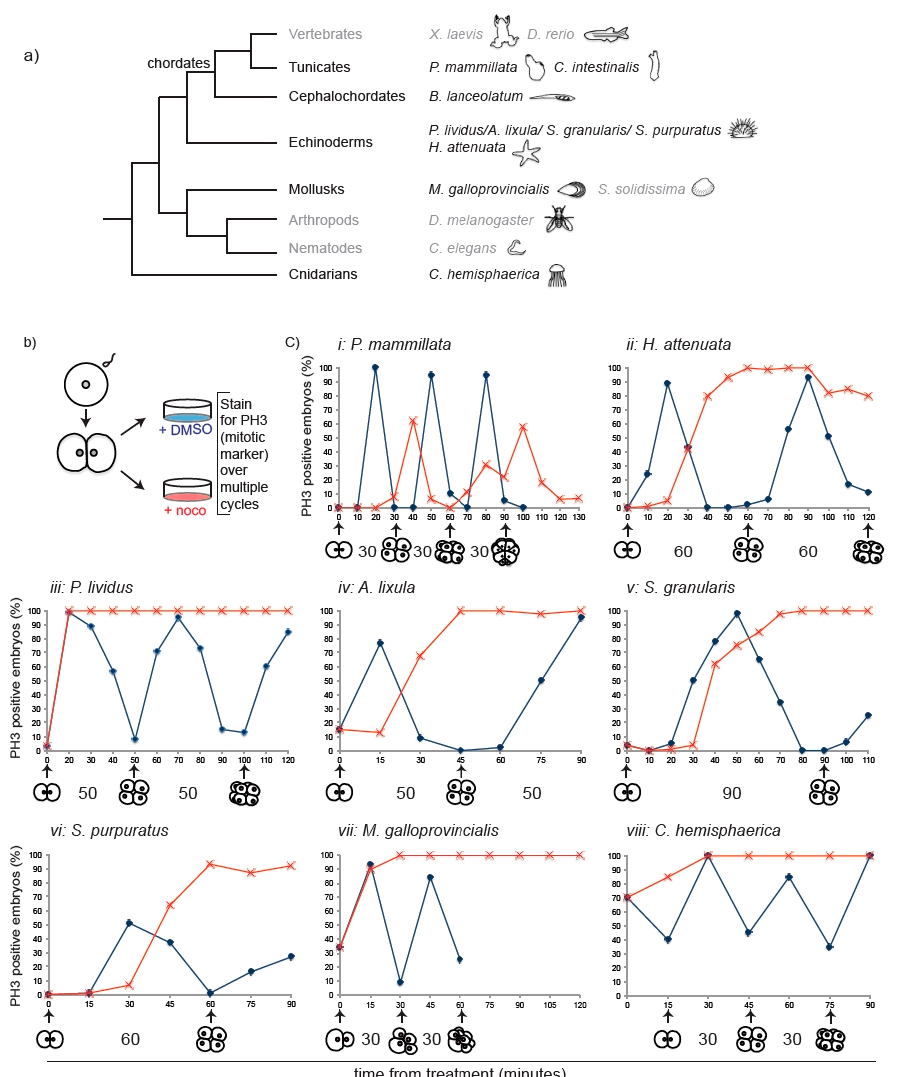
Figure 1. Nocodazole-induced spindle depolymerization defines two classes of embryos with qualitatively different mitotic responses. ( a ) Phylogenetic tree indicating phyla and species. Species analyzed in this study are in black, species for which information was obtained from the literature in grey. ( b ) Schematic representation of assay used to test mitotic progression. Two-cell stage embryos of selected species were treated either with DMSO or nocodazole and then fixed every 10–15 min for pH3 immunostaining. ( c ) Percentage of embryos accumulating pH3 in the presence of DMSO (blue) or nocodazole (red) over time (minutes indicated in x axis). Representative of 4 independent experiments, n = 50–200 embryos for each time point. Drugs were added when at least 90% of embryos were at 2-cell stage (t0). For M. galloprovincialis , control could not be quantified past 8 cells as divisions become asynchronous within each embryo. The duration of normal cell-cycle timing for each species is indicated under the corresponding graph. 3.2. The Mitotic Delay Observed in Jellyfish, Sea Urchin, and Mussel Embryos Depends on the SAC Kinase Mps1